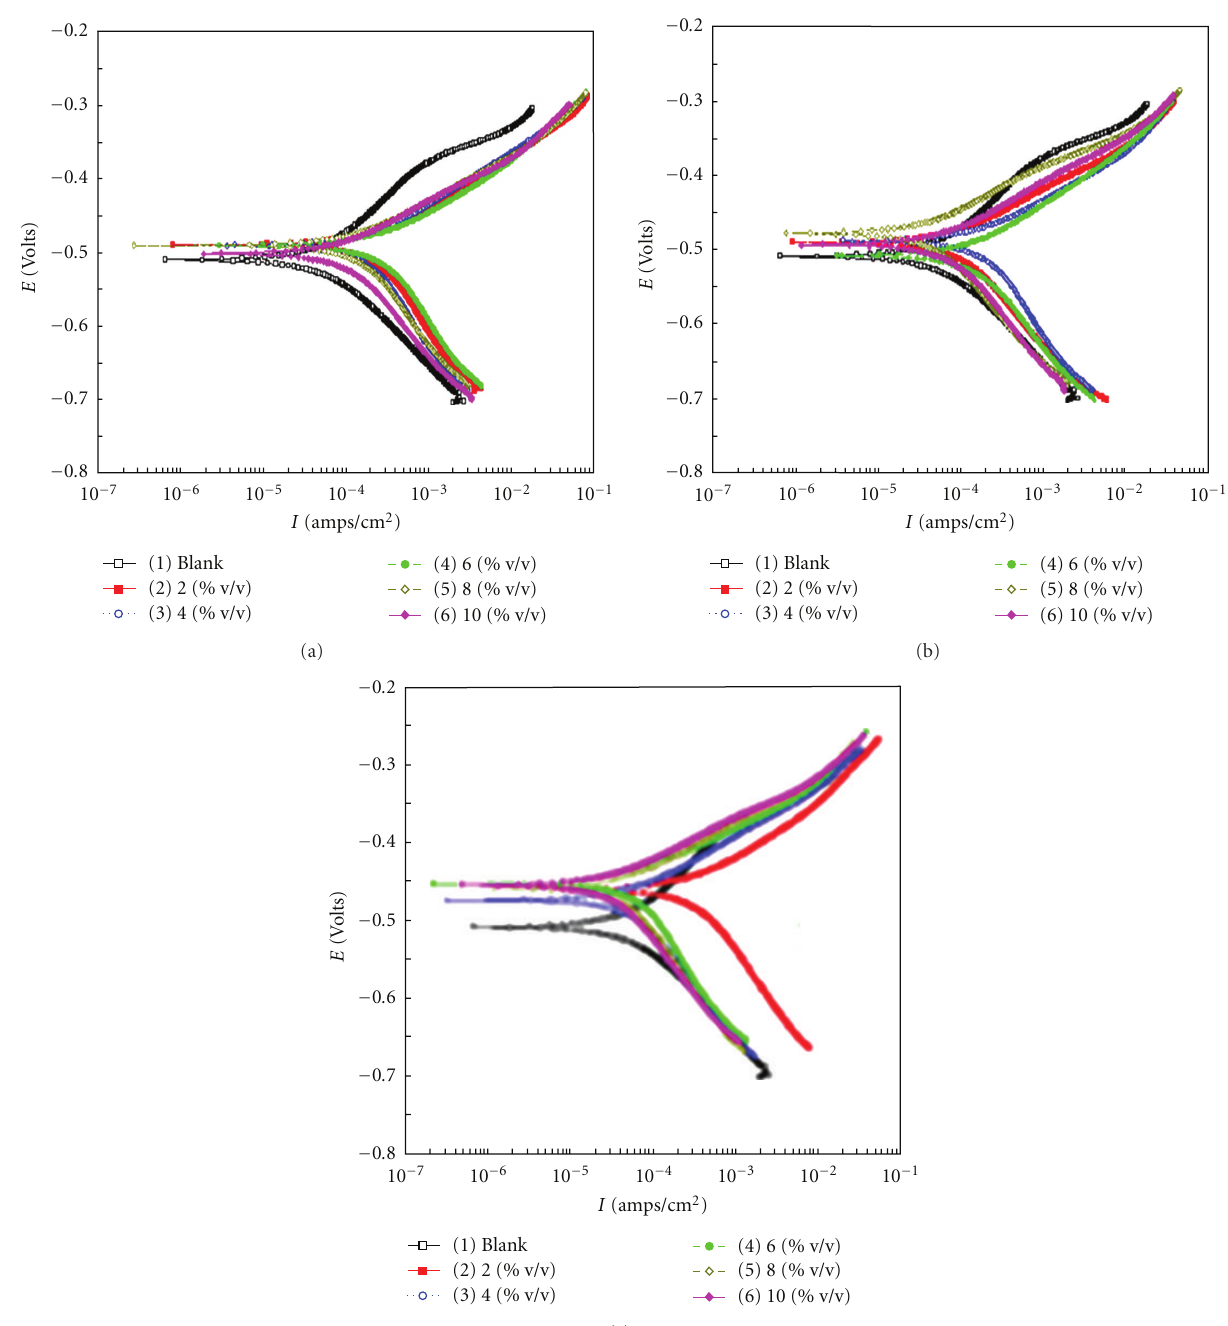
Figure 1: Potentiodynamic polarization curves for mild steel in 1N HCl solution in the absence and presence of various concentrations of the plant extracts (a) Ocimum sanctum , (b) Aegle marmelos , and (c) Solanum trilobatum .